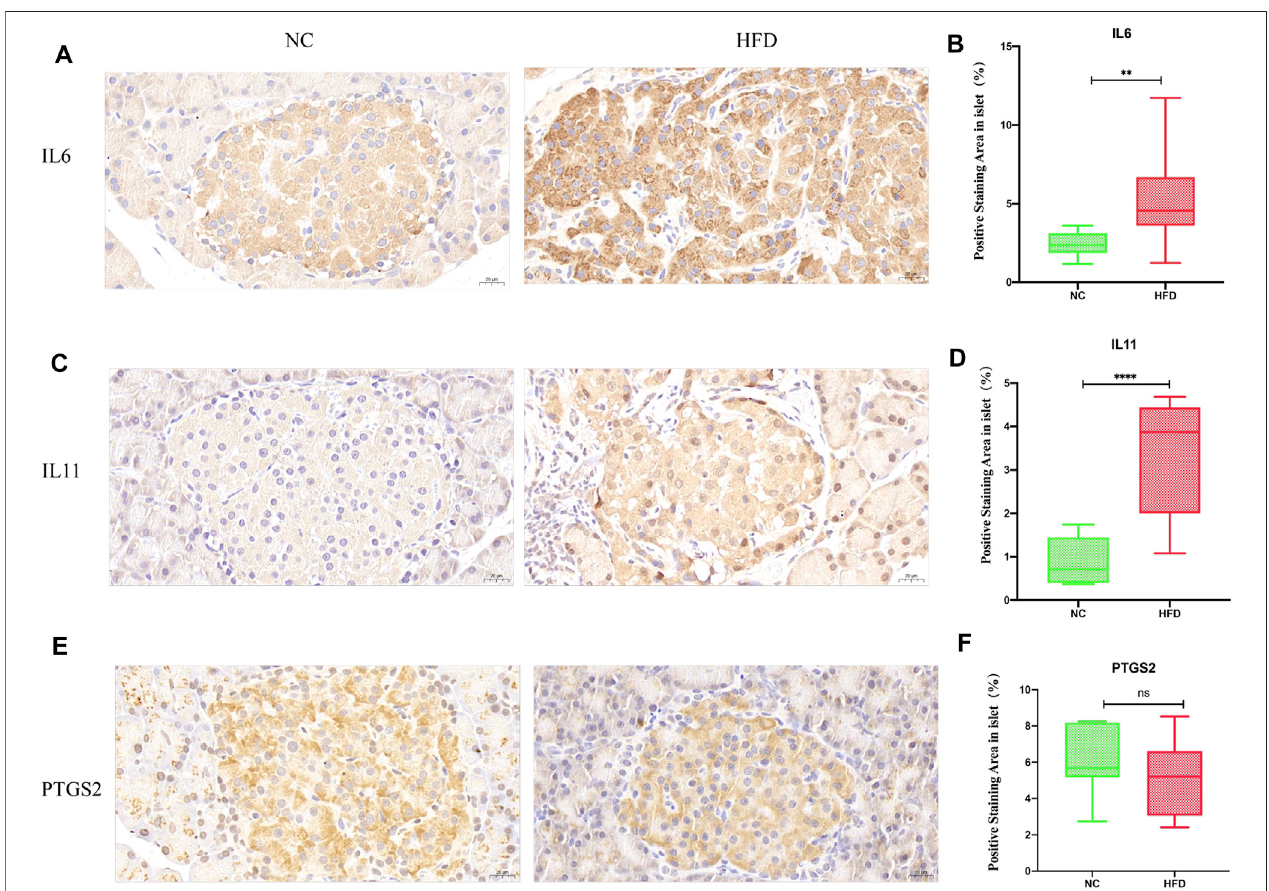
FIGURE7| Expressionofthehubgenesinislets.IL6,IL11andPTGS2wereallcytoplasmic.Nostainingorweaklypositivestainingwasde fi nedaslowexpression, and strong positive staining was de fi ned as high expression. The density of positive staining was calculated by dividing the area of brown-stained structures within the islet parenchyma by the islet area. Quanti fi cations were performed in a blind fashion. (A,B) Immunohistochemical staining showed that IL6 positivity was greater in the HFD group than in the NC group (40 × magni fi cation; scale bar: 20 µm). (C,D) Immunohistochemical staining showed that IL11 positive staining was greater in the HFDgroupthanintheNCgroup(40 × magni fi cation;scalebar:20 µm). (E,F) Therewasnosigni fi cantdifferencebetweentheHFDgroupandtheNCgroupwithregardto PTGS2 immunohistochemical staining (40 × magni fi cation; scale bar: 20 µm). The results are presented as the mean ± standard deviation. ( t -test; n (cid:2) 6 in each group). * p < 0.05,** p < 0.01,*** p < 0.001,**** p < 0.0001, n. s., not signi fi